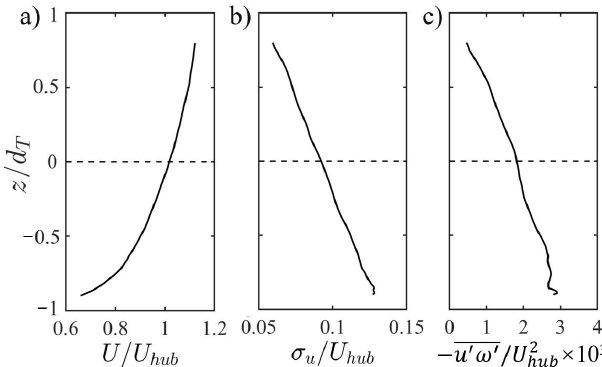
Figure 2. Characteristics of the turbulent boundary layer near the turbine: ( a ) mean velocity U / U hub ; ( b ) turbulence intensity I u = σ u / U hub ; and ( c ) kinematic shear stress − u (cid:48) w (cid:48) / U 2 dashed line indicates the hub height location of the turbine